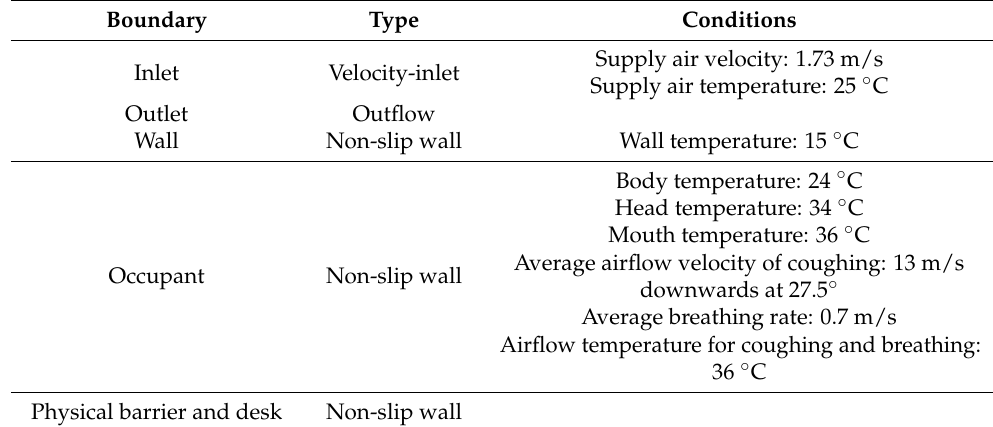
Table 2. Boundary conditions of numerical simulation